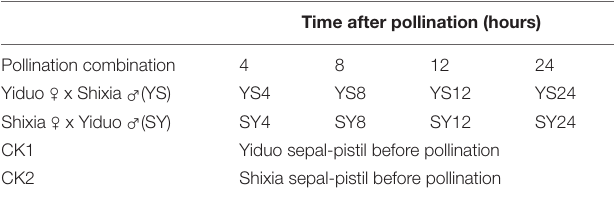
TABLE 1 | Details of longan samples used for transcriptome